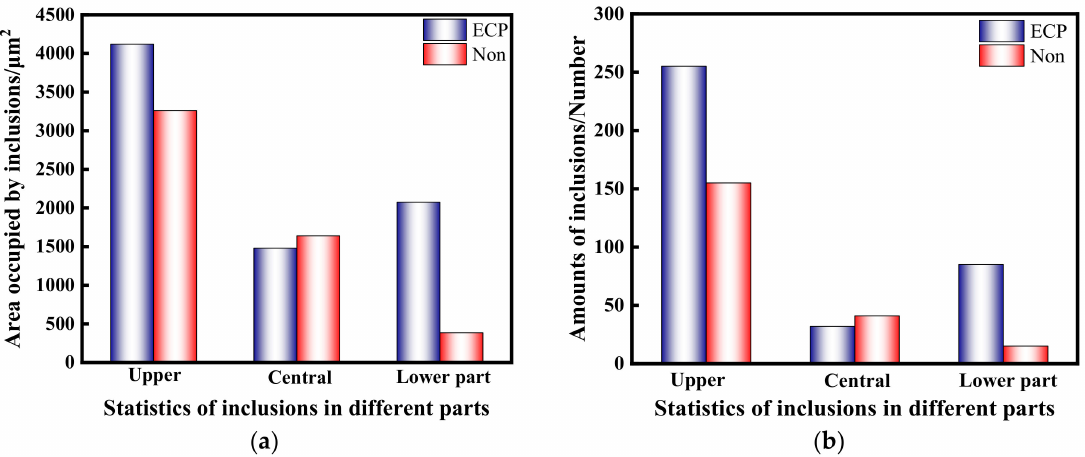
Figure 4. Statistical analysis of inclusions in the sample after electrification and non-electricity treatment. ( a ) Inclusion area statistics ( b ) Inclusion number statistics.